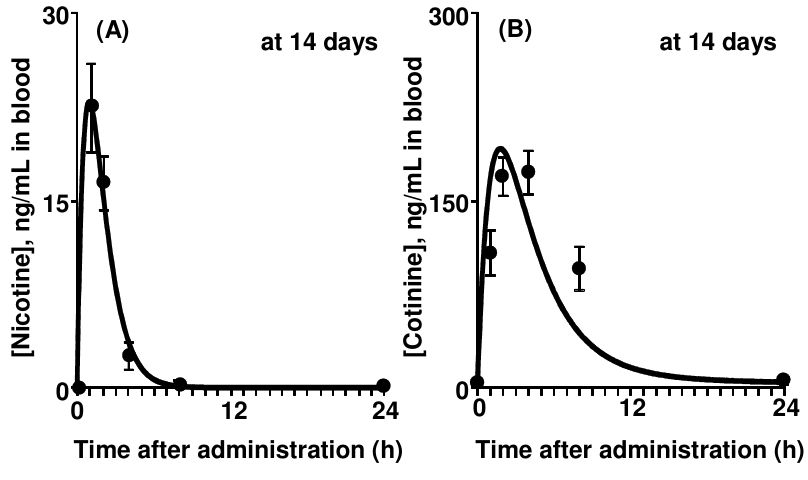
Figure 5. Measured and estimated blood concentrations in rats after oral administration of nicotine (A) and cotinine (B) for 14 days. Data points with bars represent means ± SDs (n = 5). The curves show the concentrations estimated by PBPK